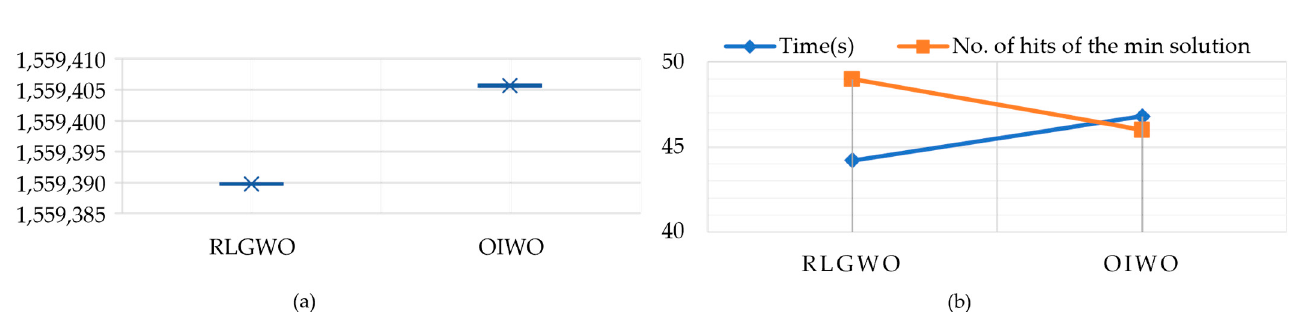
Figure 11. Results obtaind using different methods for the 140-unit system (50 trials): ( a ) boxplot of the final generation cost; ( b ) time and number of hits of the minimum solution.